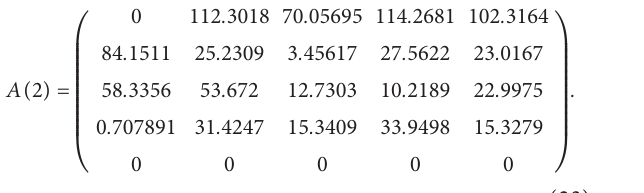
Table 5 yields the matrix: